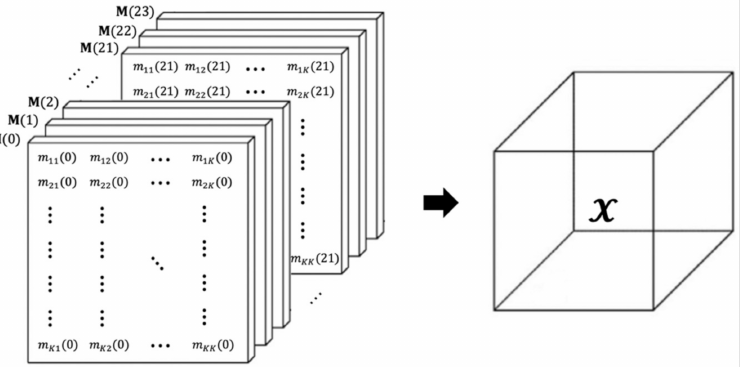
Figure 4. Establishment of the ODT